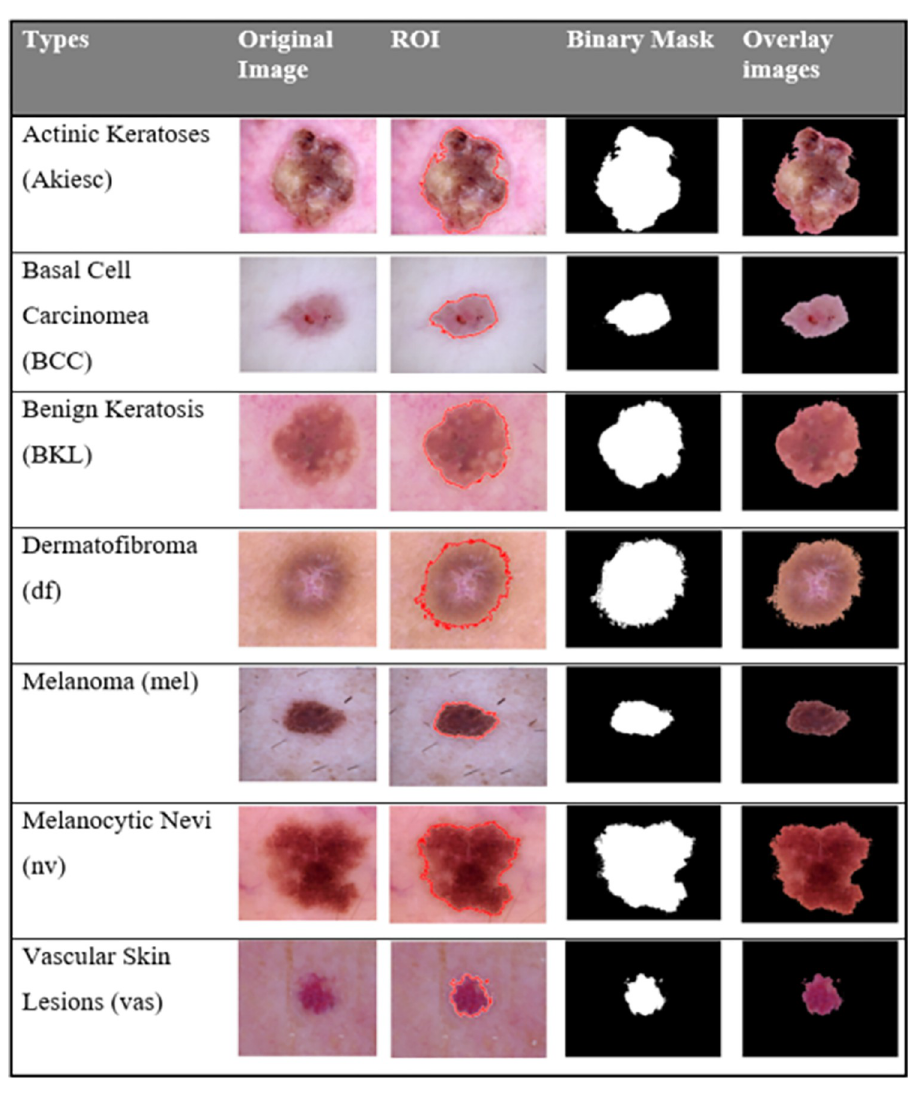
Fig 3. Samples of segmented skin